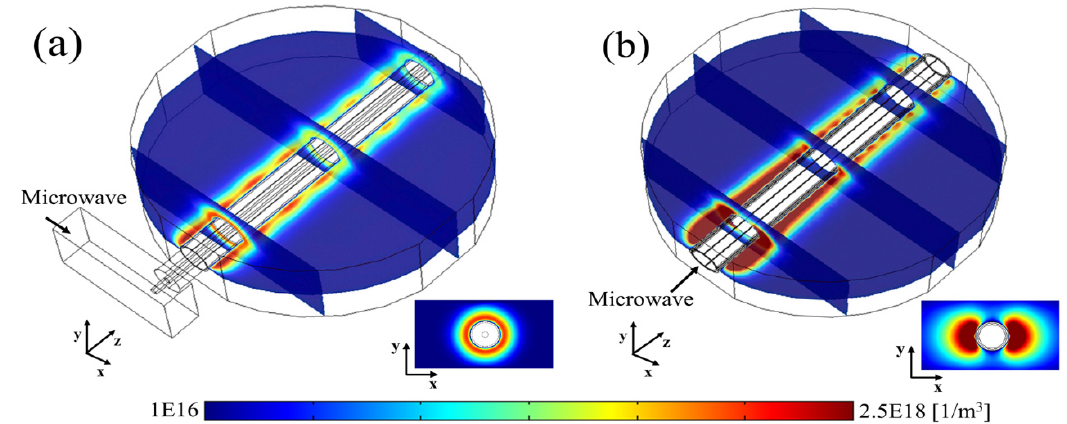
Figure 9. Electron density profile at 500 mTorr MWP. ( a ) TEM mode of quasi-coaxial linear MWP and ( b ) circular TE 11 mode waveguiding structure MWP.